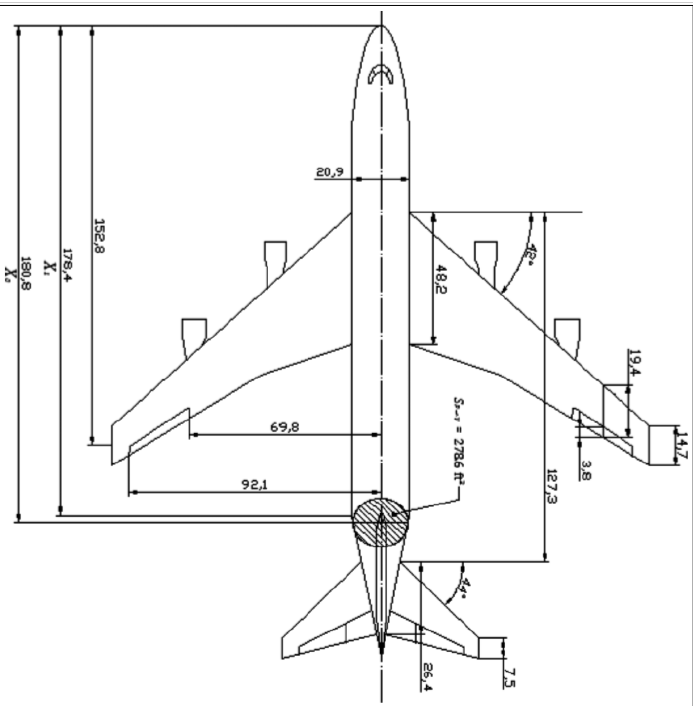
Figure 4. General dimensions of Boeing 747-200 along longitudinal, lateral, and vertical axes